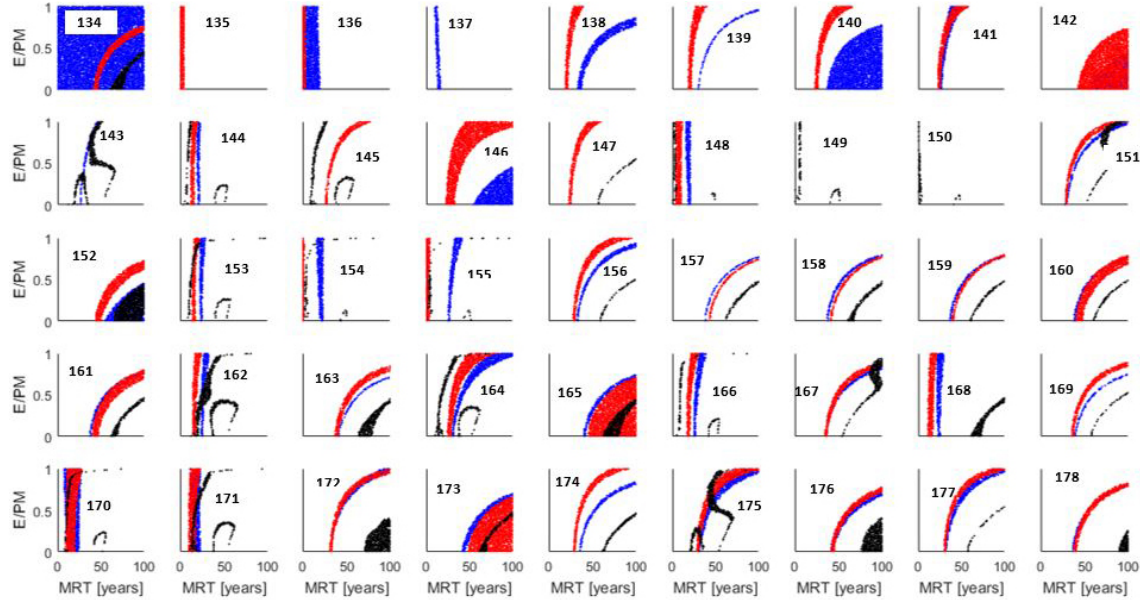
Figure A4. Behavioural age information (MRT and E / PM) inferred from SF 6 (red), tritium (black) and Halon-1301 (blue) for sites 134 to